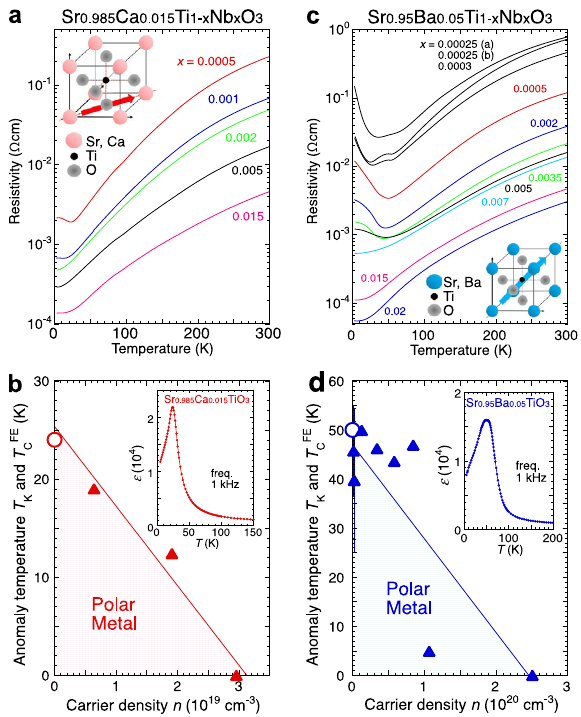
Fig. 3 Resistance anomaly as evidence of existence of polar metal. a Resistivity values of our Sr 0.985 Ca 0.015 Ti 1 − x Nb x O 3 single crystals with x = 0.0005, 0.001, 0.002, 0.005, and 0.015 plotted versus T . b Curie temperature T FE ~ 25 K of the ferroelectric transition for C undoped Sr 0.985 Ca 0.015 TiO 3 (open red circle) and temperatures T K at which the resistivity reaches a minimum for the doped samples (closed red triangles) plotted versus the carrier density n at T K (or at 5 K for T K = 0). The values of n at T K were obtained via interpolation (see the main text). The solid line represents the least-squares fi t of T K . This line is quite close to T FE at n = 0. The inset shows the C temperature dependence of the relative permittivity ε , where the of ~25 K. This value is almost equal to that peak corresponds to a T FE ffiffiffiffiffiffiffiffiffiffiffiffiffiffiffiffiffiffiffiffiffiffi p C ¼ A y (cid:2) 0 : 0018 (where A = 298 K and y = calculated using T FE C 0.015) (ref. 32 ). c Resistivity of our Sr 0.95 Ba 0.05 Ti 1 − x Nb x O 3 single crystals with x = 0.00025, 0.0003, 0.0005, 0.002, 0.0035, 0.005, 0.007, 0.015 and 0.02. d T FE ~ 50 K for undoped Sr 0.95 Ba 0.05 TiO 3 (open blue C circle), which corresponds to the peak of ε (see the inset), and T K values for the doped samples (closed blue triangles) plotted versus n at T K . The de fi nition of the error bars is provided in the main text. The solid line represents the least-squares fi t for T K